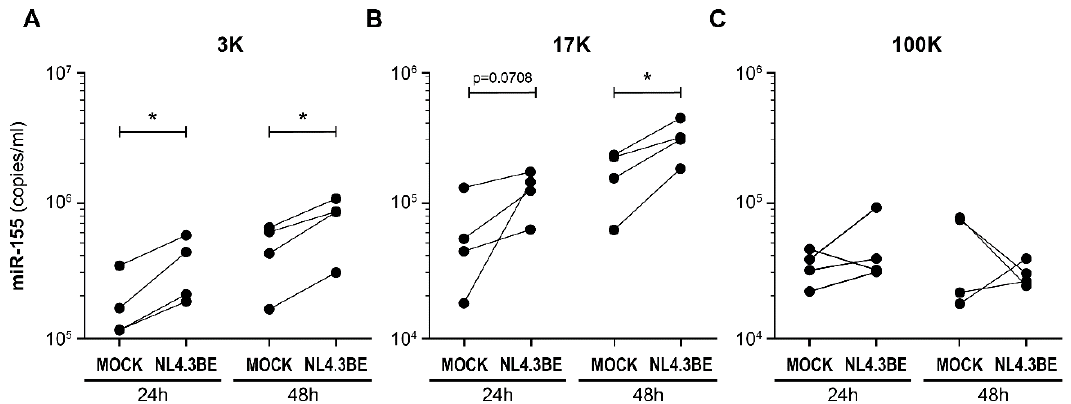
Figure 3. HIV-infected PBMCs release miR-155-rich large EVs. PBMCs freshly isolated from HIV- negative donors (n = 4) were incubated with NL4.3Bal env virus (100 ng of p24 per 10 6 cells) or diluent for 2 h, washed three times with PBS to eliminate free virus, then incubated for 24 h or 48 h. Culture supernatants were incubated with 1 mM AT-2 to inactivate viral particles, then centrifuged sequentially at 3000 × g (3K) ( A ), 17,000 × g (17K) ( B ), and 100,000 × g (100K) ( C ). Mature miR-155 in EVs was quantified by RT-qPCR, using a standard curve produced using synthetic miR-155. Each dot represents one donor. The significant difference (* p < 0.05) is based on parametric paired t-tests to compare the EVs derived from infected PBMCs versus the EVs derived from non-infected PBMCs (Mock).